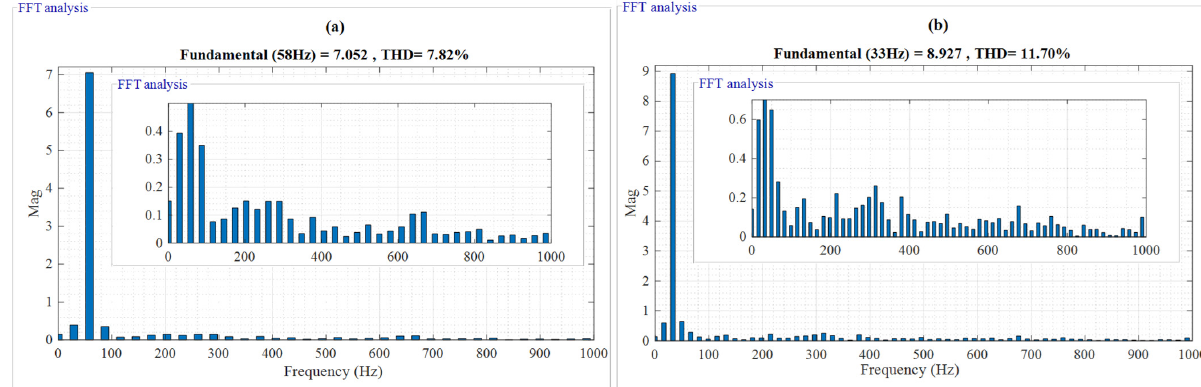
Figure 14. Stator ( a ) and rotor ( b ) THD of classical DTC.